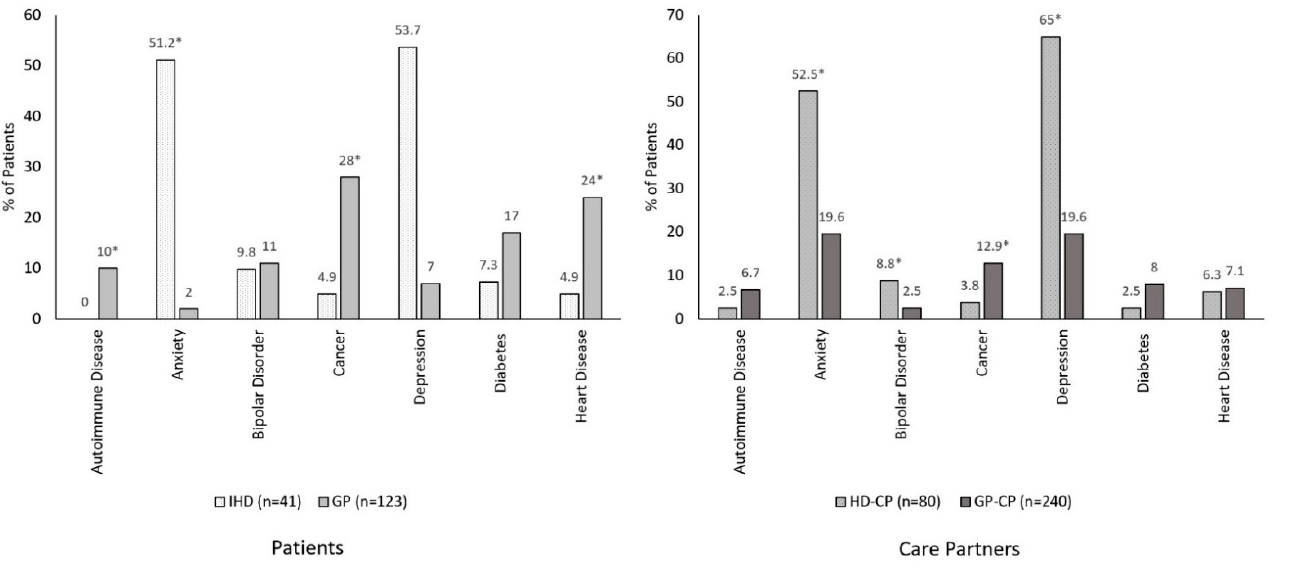
Figure 5. Comorbidities among HD relative to GP. All comparisons adjusted for age and sex using propensity-score matching. * p < 0.05. CP, care partner; GP, general population; IHD, individuals with Huntington’s disease.